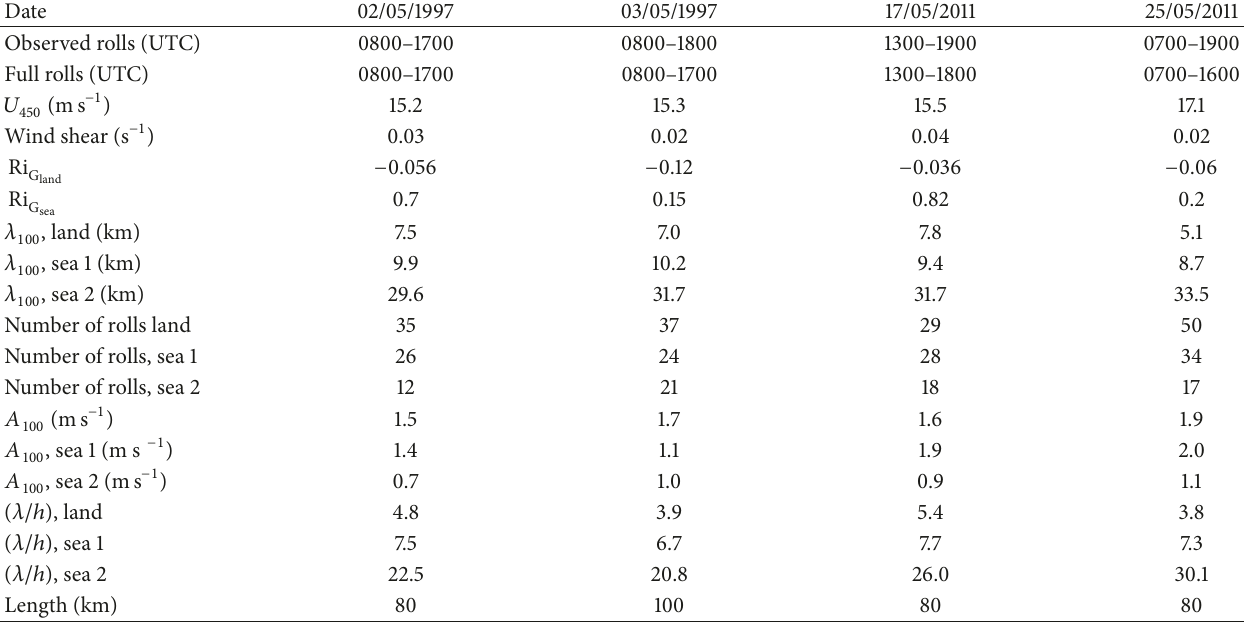
Table 4: Data from WRF simulations during the four days, showing meteorological conditions and roll characteristics taken from the study area as described in Section